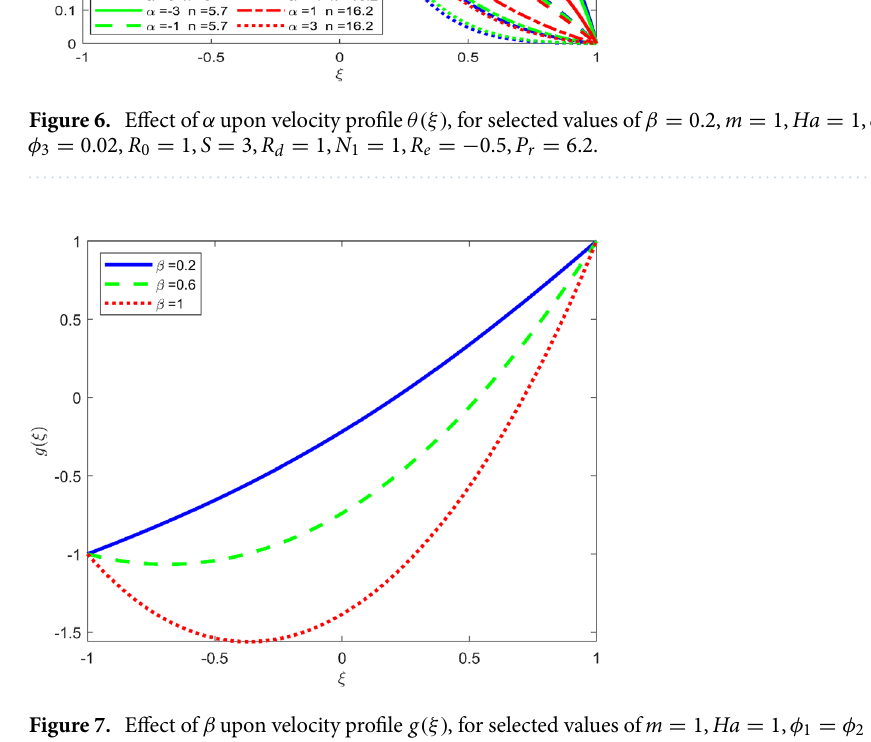
Figure 7. Effect of β upon velocity profile g (ξ) , for selected values of m R